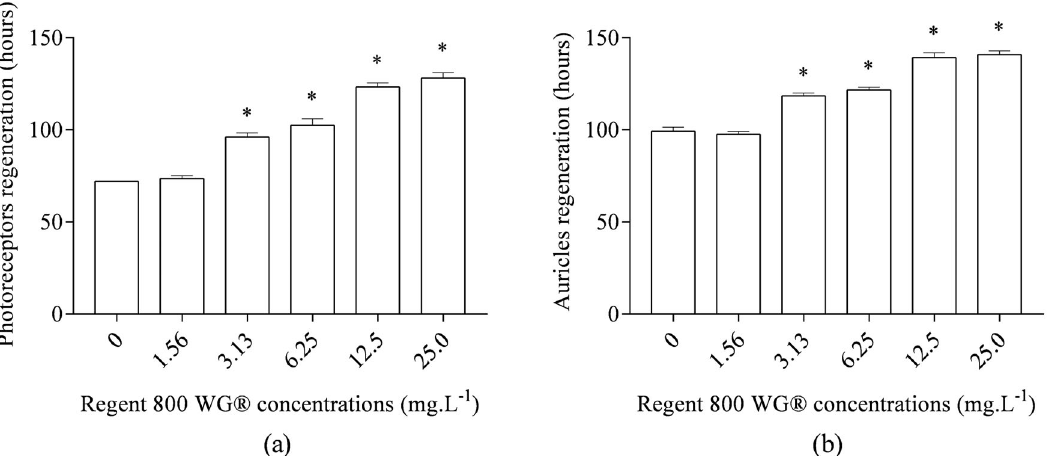
Figure 2. Effects of sublethal concentrations of Regent 800 WG ® insecticide on the regeneration of G. tigrina . ( a ) Photoreceptor regeneration. ( b ) Auricles regeneration. Concentrations refer to active ingredient of fipronil. The exposure time was sixteen days. Data are presented as mean ± standard error, n = 15. * Significant differences are observed in comparison with the control treatment (Dunn’s post hoc test).